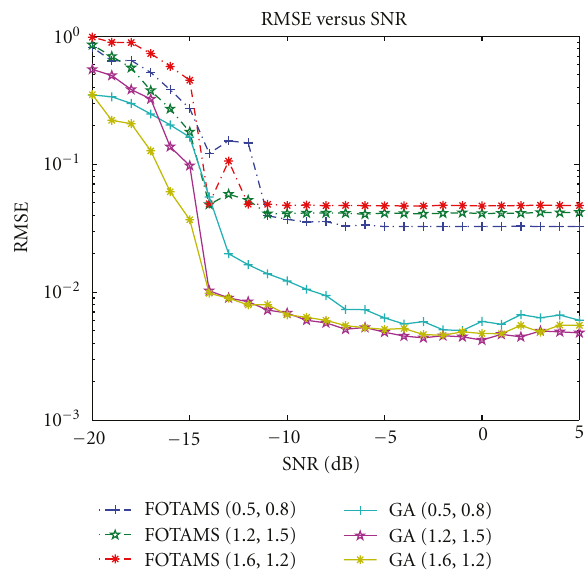
Figure 2: RMSEs of frequency estimation versus the SNR, e ( m , n ) is white Gaussian noise, the data size is 50 × 50.